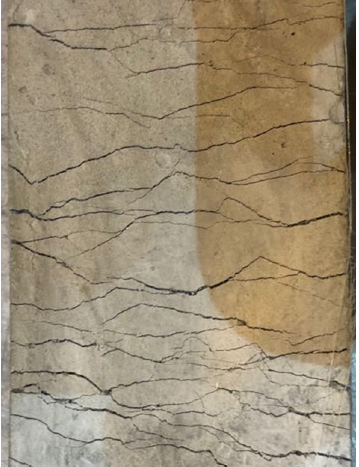
Figure 5. Test setup (tensile test system, Xinsansi, Shenzhen, China) for direct tension